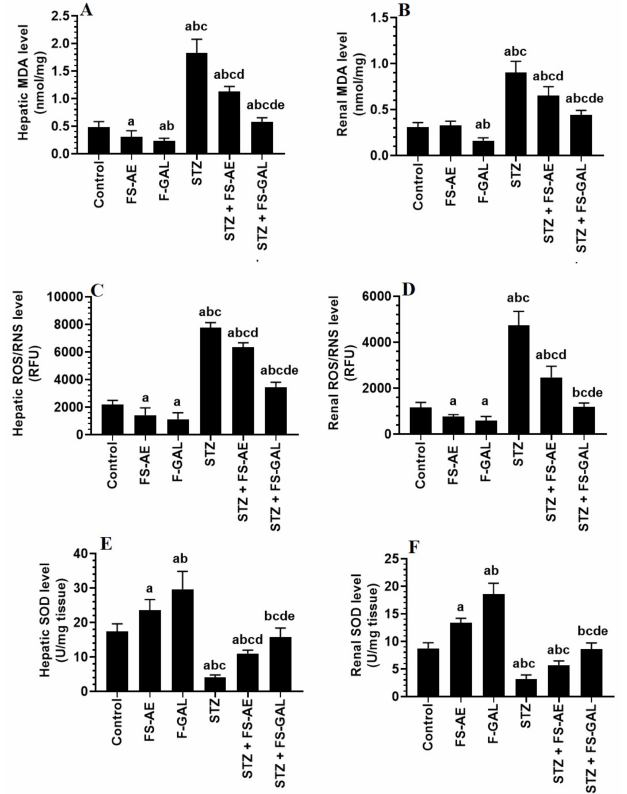
Figure 1. Levels of malondialdehyde (MDA) ( A , B ), reactive oxygen/nitrogen species (ROS/RNS) ( C , D ), and Superoxide Dismutase (SOD) ( E , F ) in the liver and kidneys of all groups of rats. All values are shown as means ± SD ( n = 8/group). a : vs. control rats, b : vs. Fenugreek seed aqueous extract (FS-AE)-treated rats, c : vs. Fenugreek seeds galactomannan-treated rats. d : vs. streptozotocin (STZ)-diabetic rats, e : vs. STZ + FS-AE-treated